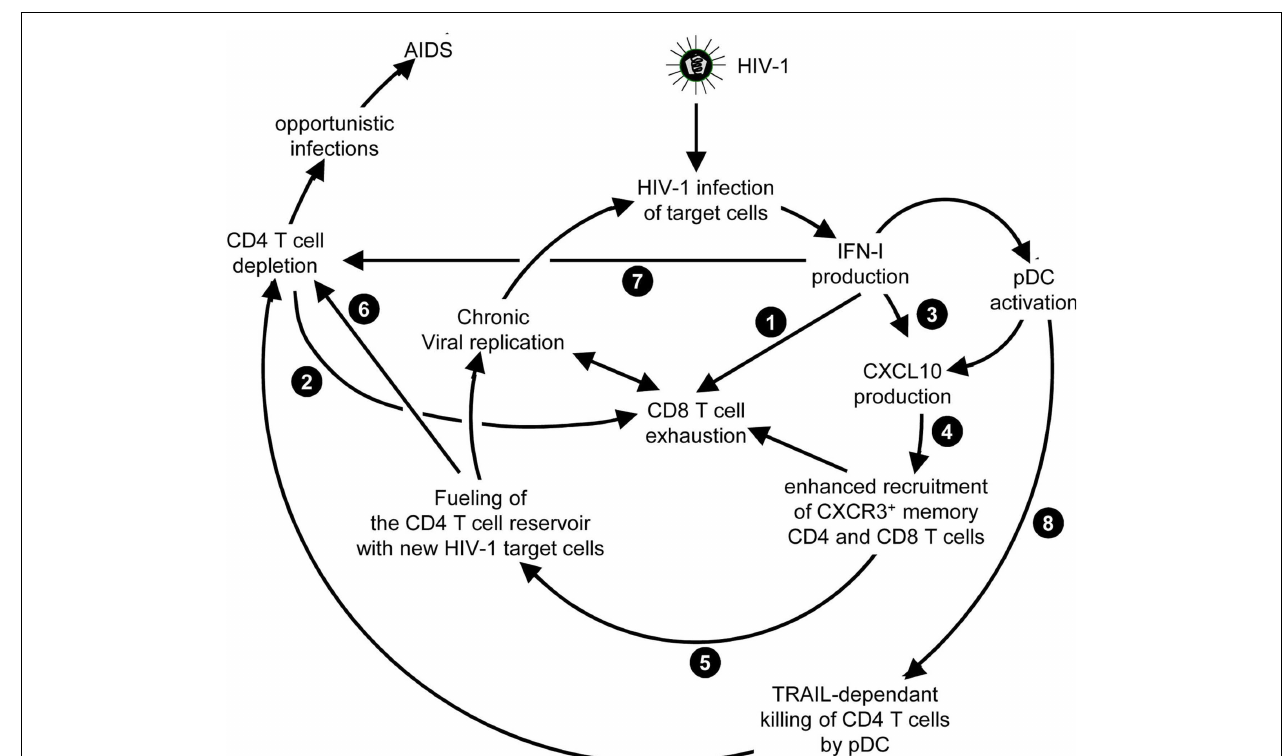
promotion of the exhaustion of anti-viral CD8T cell responses, as well as direct ( ) and indirect ( -to- , and ) promotion of CD4T cell depletion with a proposed central role of pDC in this deleterious process. Altogether, these mechanisms may sustain a vicious circle of reciprocal activation between chronic viral replication and deleterious immune responses, driving the progressive depletion of all CD4T cells ultimately causing the enhanced susceptibility to opportunistic infections characteristic of the acquired immunodeficiency syndrome (AIDS). See main text for further